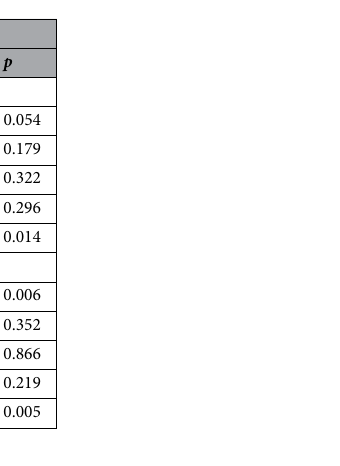
Table 4. Cox-regression analysis of triple-positive